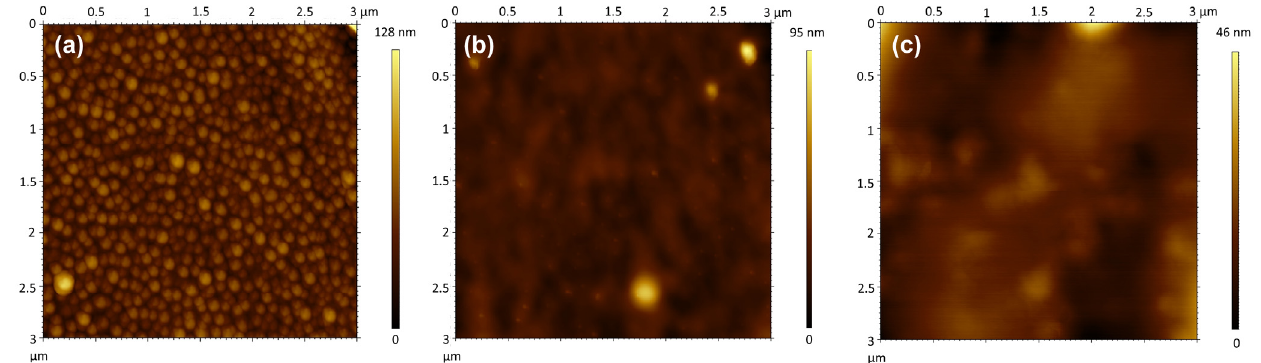
Figure 6 . Surface topography images obtained by AFM for the ( a ) plasma-treated PET, with 15 kW power and 4 m/min speed; ( b ) NaAc-grafted PET; and ( c ) Kac-grafted PET.